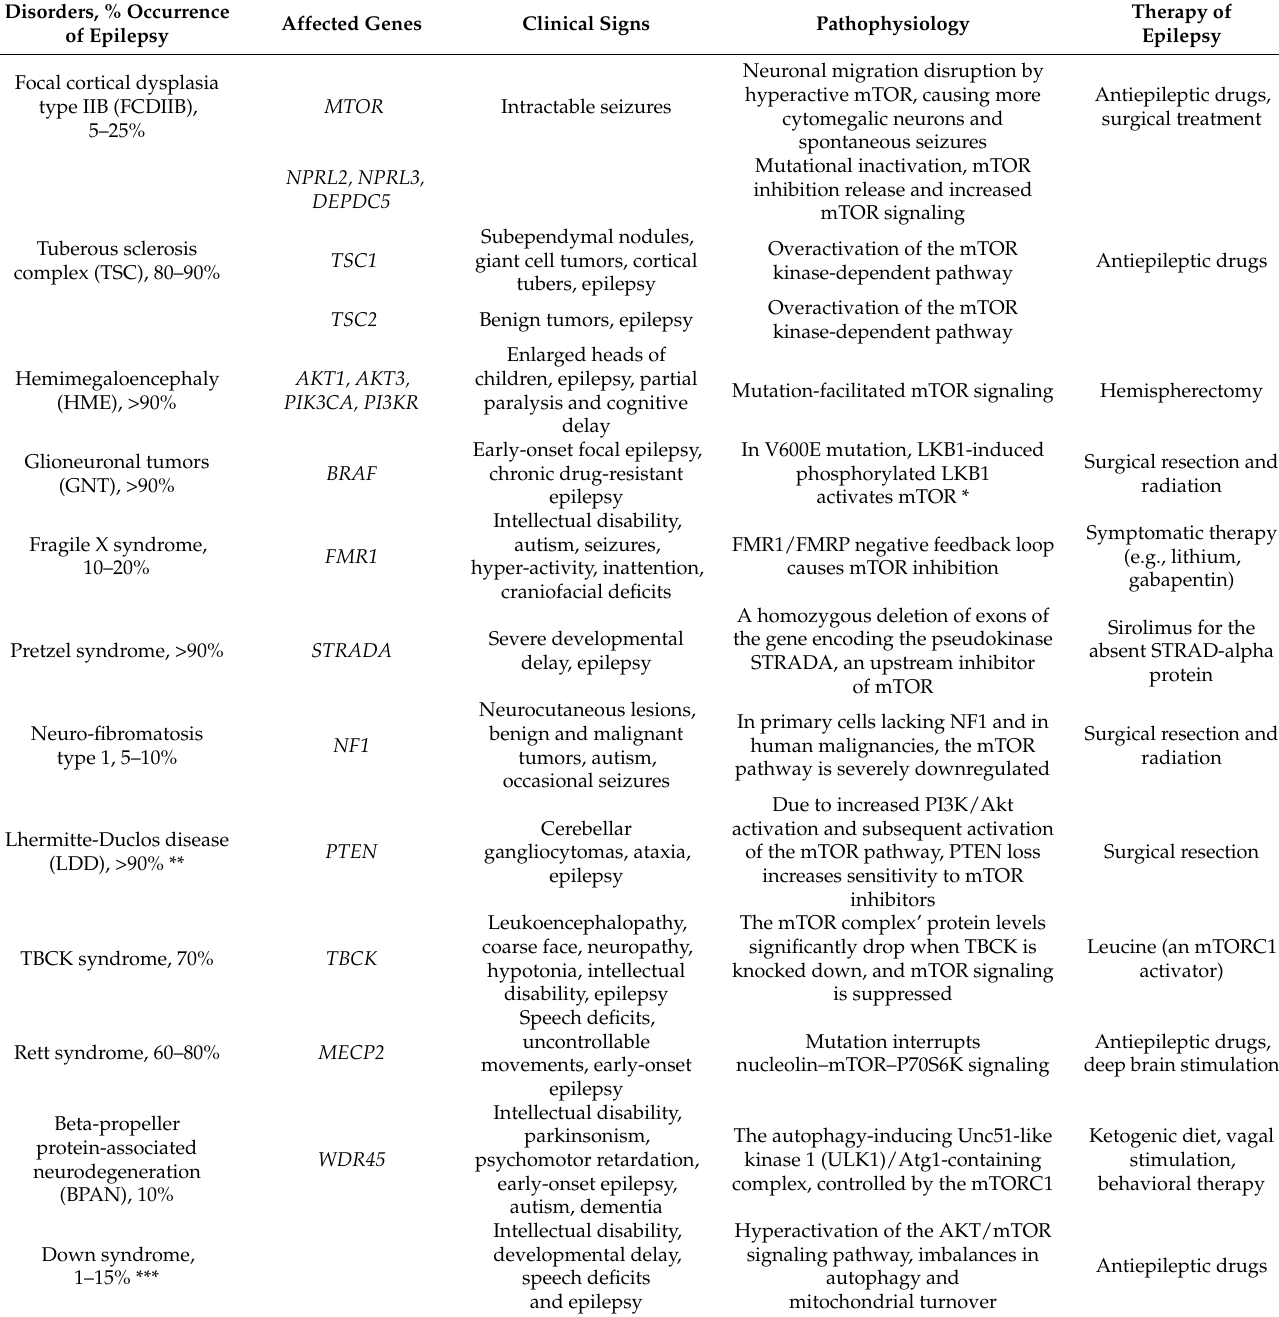
Table 1. A brief summary of selected clinical mTORopathies (also see Figure